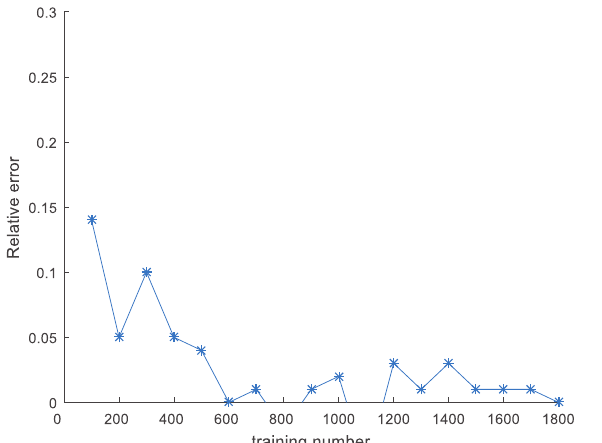
Figure 8. Relative inaccuracy of the FNNRW learning method that has been improved. The optimized FNNRW learning algorithm’s relative errors show a downward trend as training times increase, and the majority of them are lower than 0.05, which is much lower than the FNNRW learning algo- rithm’s relative error of 0.1, demonstrating the optimized FNNRW algorithm’s superior